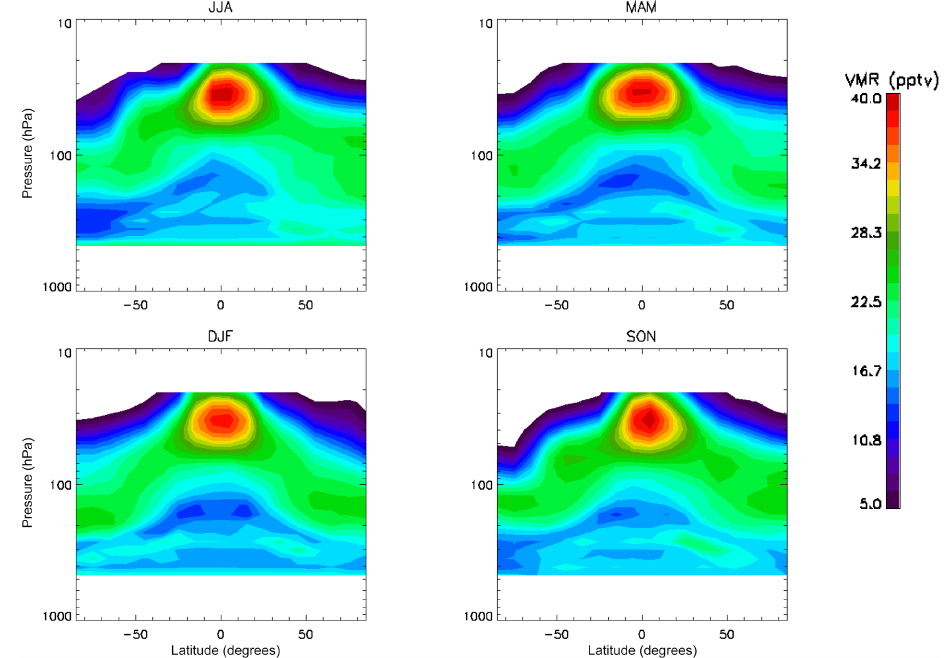
Figure 6. Zonal average phosgene VMR for JJA (top left), MAM (top right), DJF (bottom left) and SON (bottom right). Averages are calculated for 10 ◦ latitude